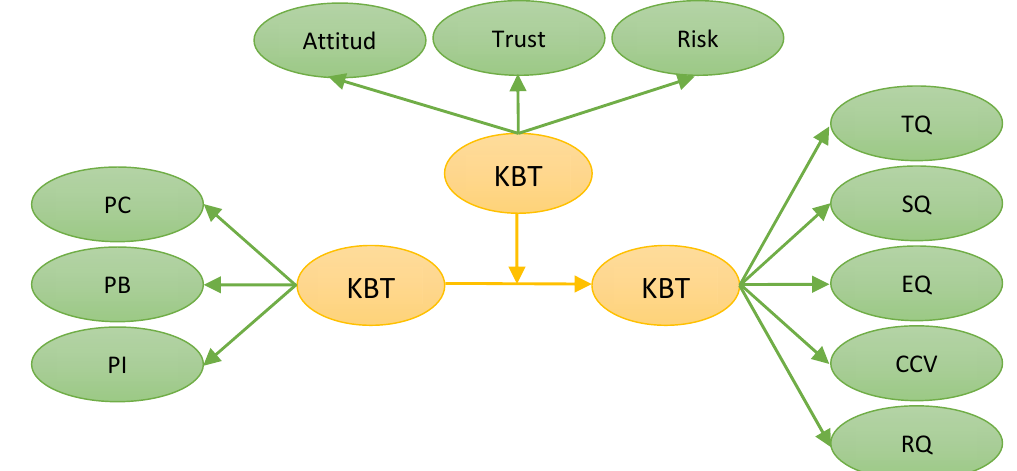
Fig. 1: Conceptual model of research (Lin, 2011; Hu et al ., 2019; Leonard,